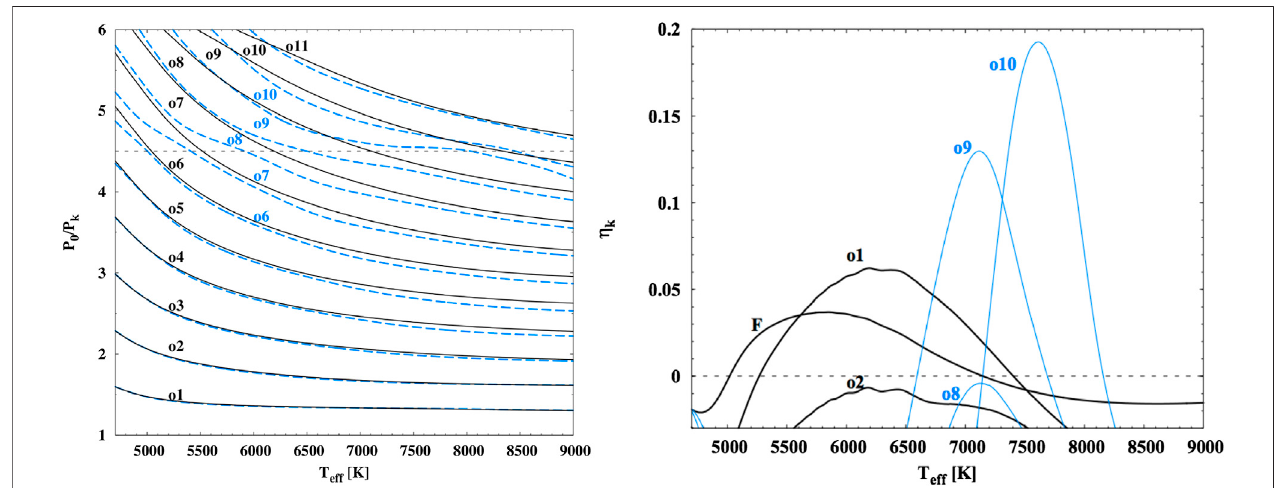
FIGURE3|Left: ModaldiagramofanRRLyraemodelsequence(Kolláthetal.,2011).Periodratiosofadiabaticmodes(blacklines)andnonadiabaticmodes(blue dashedlines).The9/2periodratioisindicatedwiththehorizontaldashedline. Right: Lineargrowthratesofradialmodes.Overtonesnineandtencouldbecomeexcited. Figure reproduced from Figures 3 and 4 of Kolláth et al.